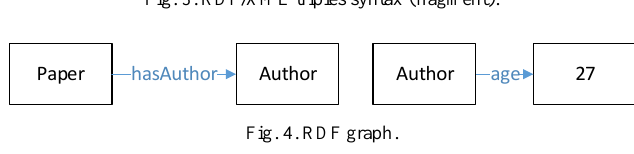
Fig. 3. RDF/XML triples syntax (fragment).